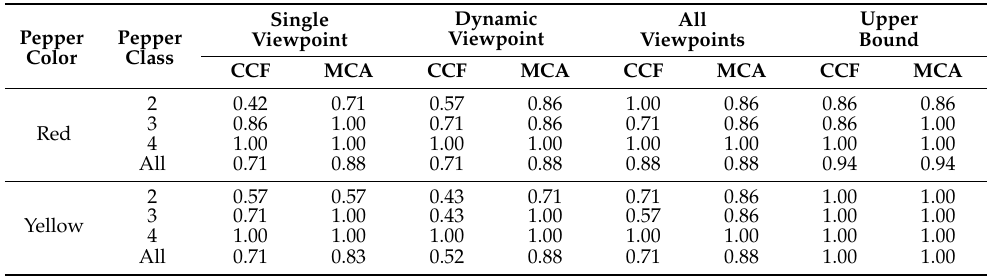
Table 5. Differences in consistent classification factor (CCF) and majority classification accuracy (MCA) for single viewpoint, dynamic viewpoint selection, all viewpoints, and the upper